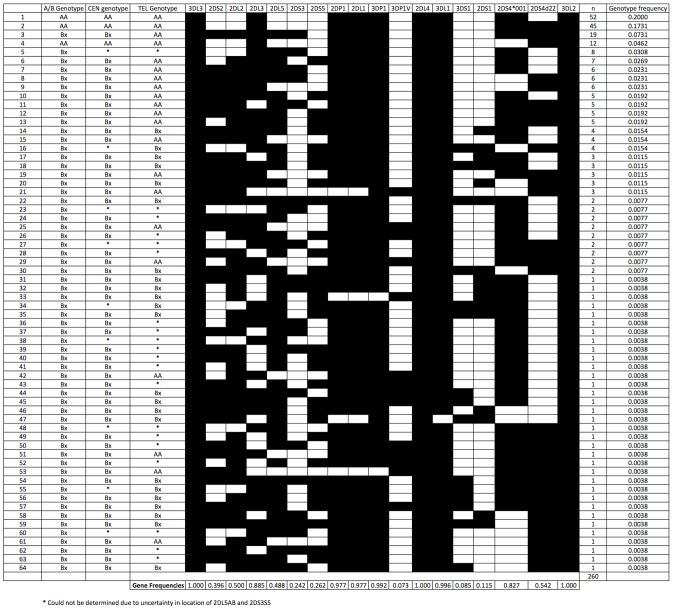
KIR genotypes and observed frequencies in the P0 population (n = 260).